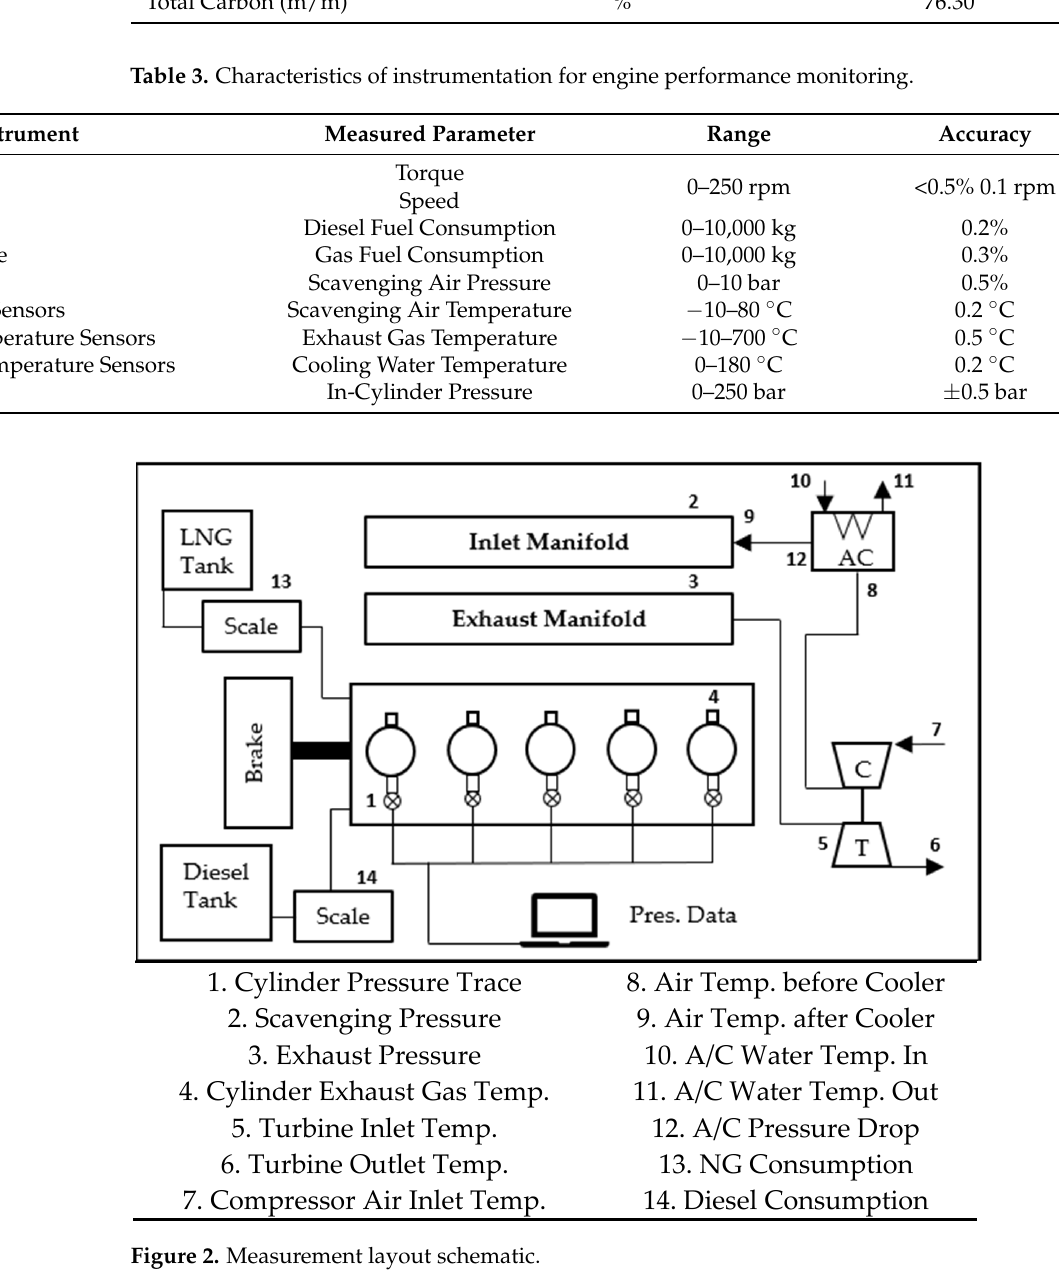
76.30 Table 3. Characteristics of instrumentation for engine performance monitoring. Instrument